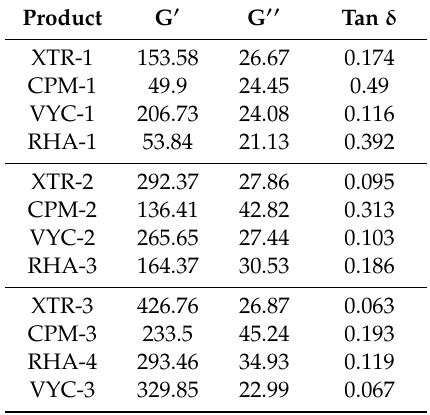
Table 2. Comparison of representative fillers from each range with similar HA concentrations.